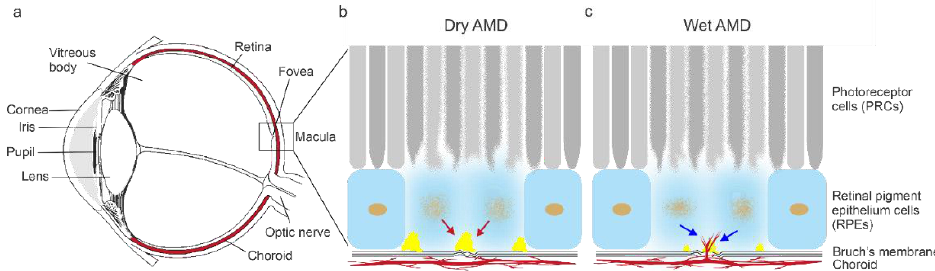
Figure 1. A parasagittal section of the eye ( a ). The clinical hallmarks of dry AMD are an accumulation of extracellular “drusen” deposits (red arrow) and degeneration of RPE cells leading to loss of PRCs ( b ). Wet AMD is characterized by the occurrence of choroidal neovascularization (blue arrow) ( c ).